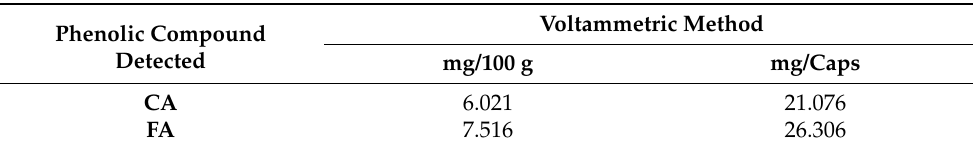
Table 5. Quantitative data of the CA and FA determination in the Eye Blend product using CNF/C- SPE.